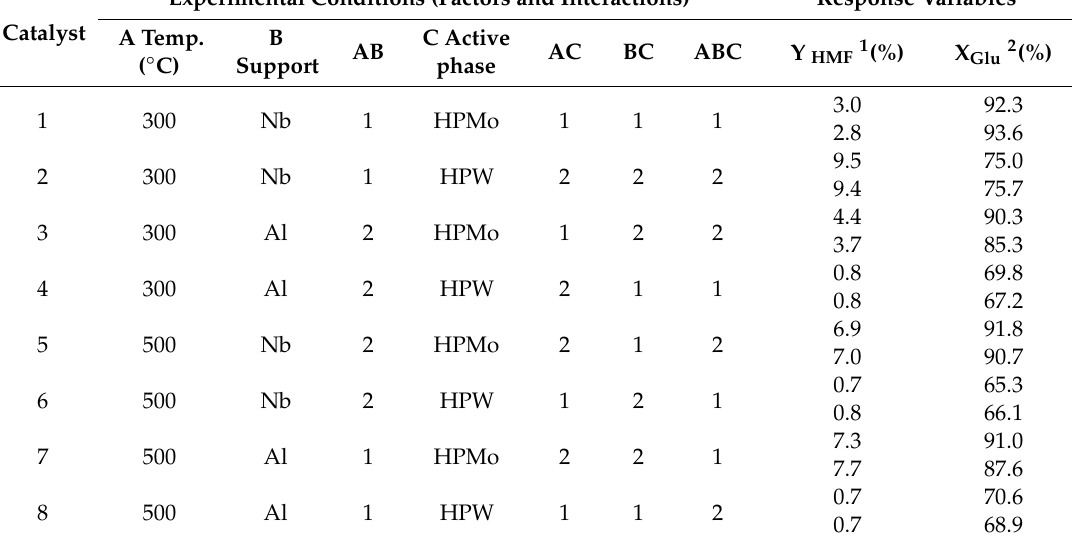
Table 1. Taguchi’s L 8 orthogonal array to evaluate the e ff ect of calcination temperature, support and active phase on heterogeneous catalysts preparation on 5-Hydroxymethylfurfural yield (Y HMF ) and glucose conversion rate (X Glu